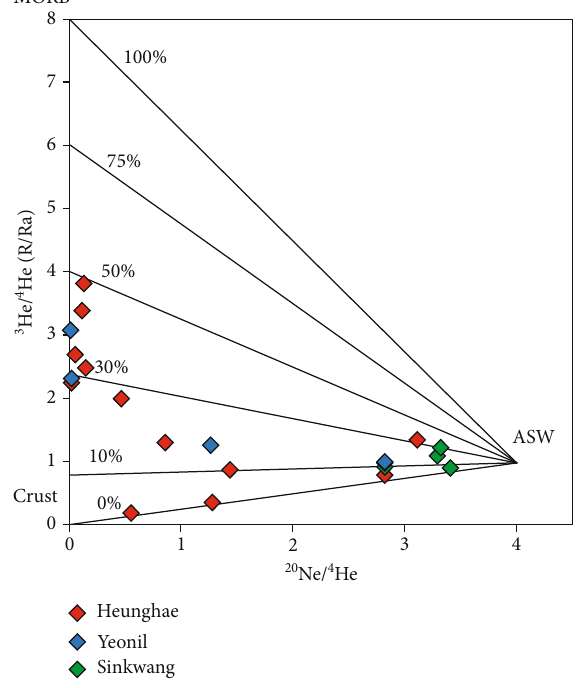
Figure 4: 3 He/ 4 He versus 20 Ne/ 22 Ne diagram. The reference values for MORB, ASW, and Crust are shown. Each line represents mixing lines between ASW and external helium sources with di ff erent MORB